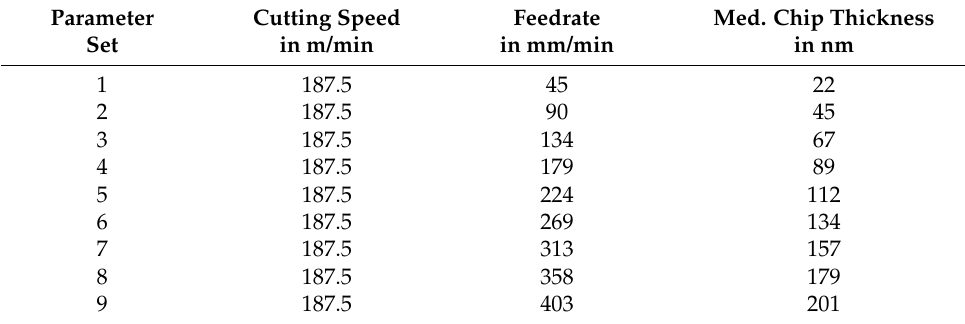
Table 3. Overview of the second experiment series.